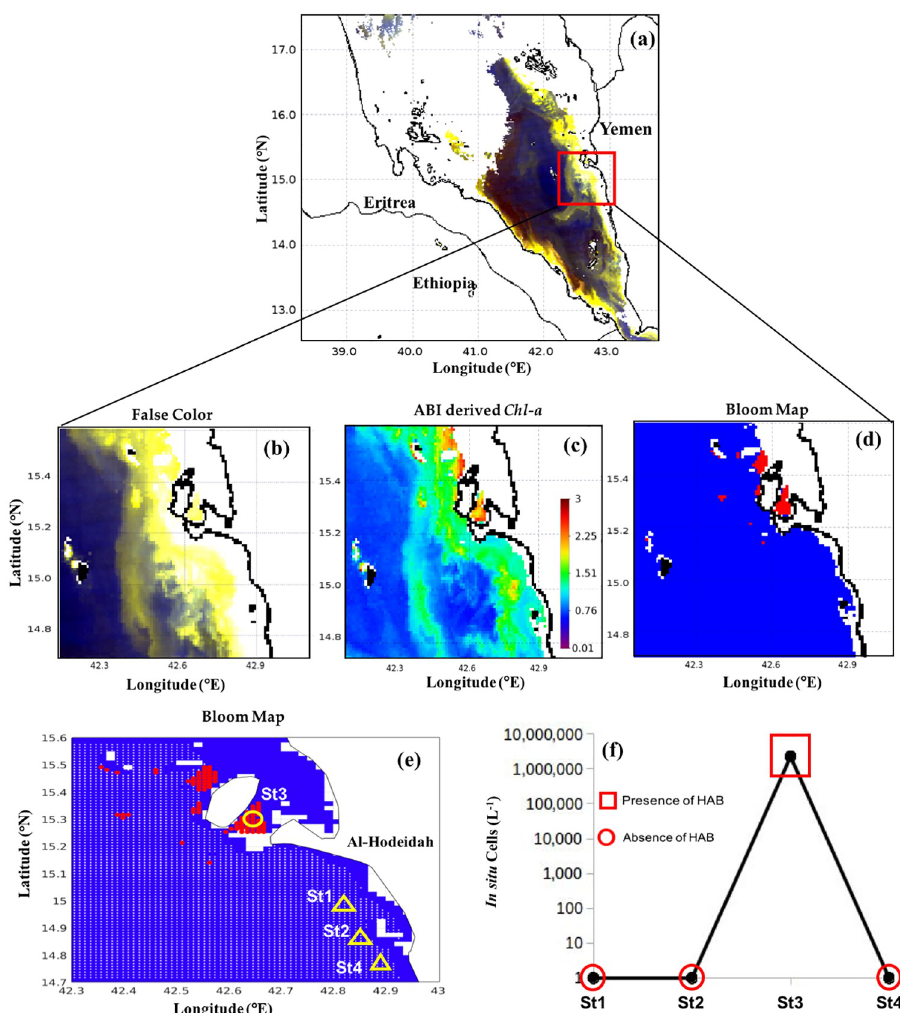
Fig 8. Remotely sensing K. foliaceum blooms in the southern Red Sea and comparison with in situ measurements. (a) and (b) False color composite image generated using the NIR, green and blue reflectances (i.e., R = R R rs (547), B = R rs (443)). (c) Satellite-derived Chl-a using ABI algorithm. (d) and (e) MODIS-Aqua-derived maps of the K. foliaceum blooms in the Red Sea on 8 th May 2013 [In (e) the red and white dots denote the presence and absence of HABs, respectively, as detected using satellite data. Also, the yellow circle and yellow triangles indicate the in situ sample points and highlight the presence and absence of K. foliaceum blooms, respectively]. (f) Variations in K. foliaceum cell counts recorded from the four different sampling stations in the coastal waters of Al Salif, southern Red Sea on 8 th May 2013 [red squares and red circles denote satellite detection of HAB presence and absence, respectively]. each of the observed HAB species. In addition, we also computed the area density for each HAB species, based on the spatial coverage of bloom pixels (area covered by the HAB event) and their corresponding in situ phytoplankton cell counts. Fig 11b shows the variations in the area density of the different HAB species observed in the Red Sea. The area density of T. ery- thraeum was the lowest (0.3 kg m -2 ) amongst all of the species because of their low cell abun- dance (1.6 � 10 4 L -1 ), whilst the highest was observed for H. akashiwo with an area density of 540 kg m -2 . The second highest area density was attributed to K. foliaceum (29 kg m -2 ). The overall area density pattern of HAB species followed the trend H. akashiwo > K. foliaceum > N. scintillans/miliaris > Ostreopsis sp . > T. erythraeum .